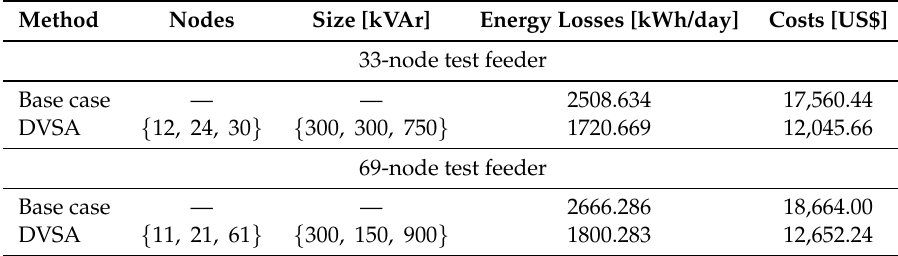
Table 5. Optimal location of capacitor banks in the 33- and 69-node test feeders considering daily load